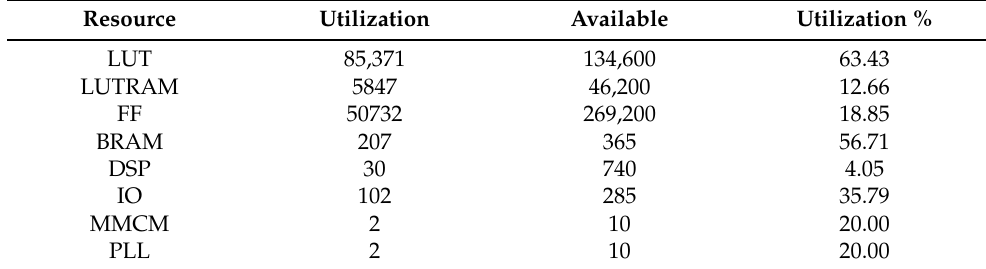
Table 1. Resource costs and